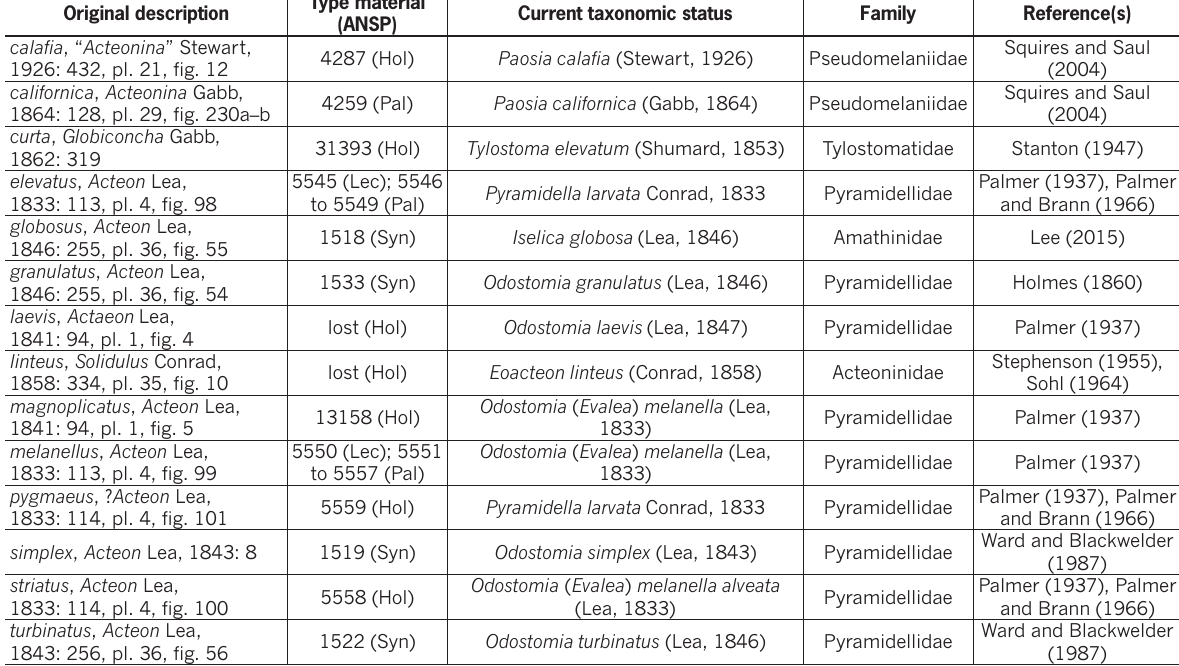
Table 1. Species (with type material in the ANSP collection) that were originally classified in Architectibranchia and Cephalaspidea, but that after revision were reclassified in other groups. The species are arranged in alphabetical order of the specific epithets, with information on their original description, type specimens in the ANSP collection, current taxonomic status, and references of such status. Abbreviations: Hol = holotype; Lec = lectotype; Pal = Paralectotype(s); Par = paratype(s); Syn =